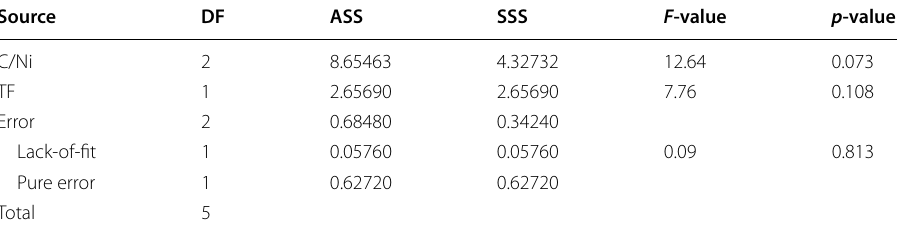
DF degrees of freedom, ASS adjusted sum of squares, SSS sequential sums of squares